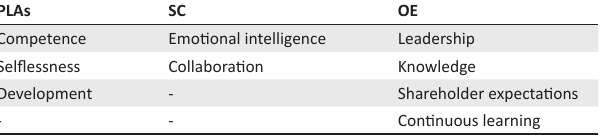
TABLE 1-A6: Items that did not reach consensus by experts. PLAs SC